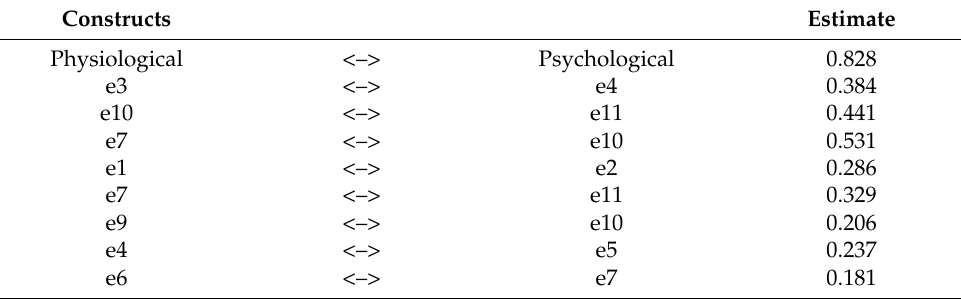
Table 8. Estimate correlations of the two constructs of the measurement